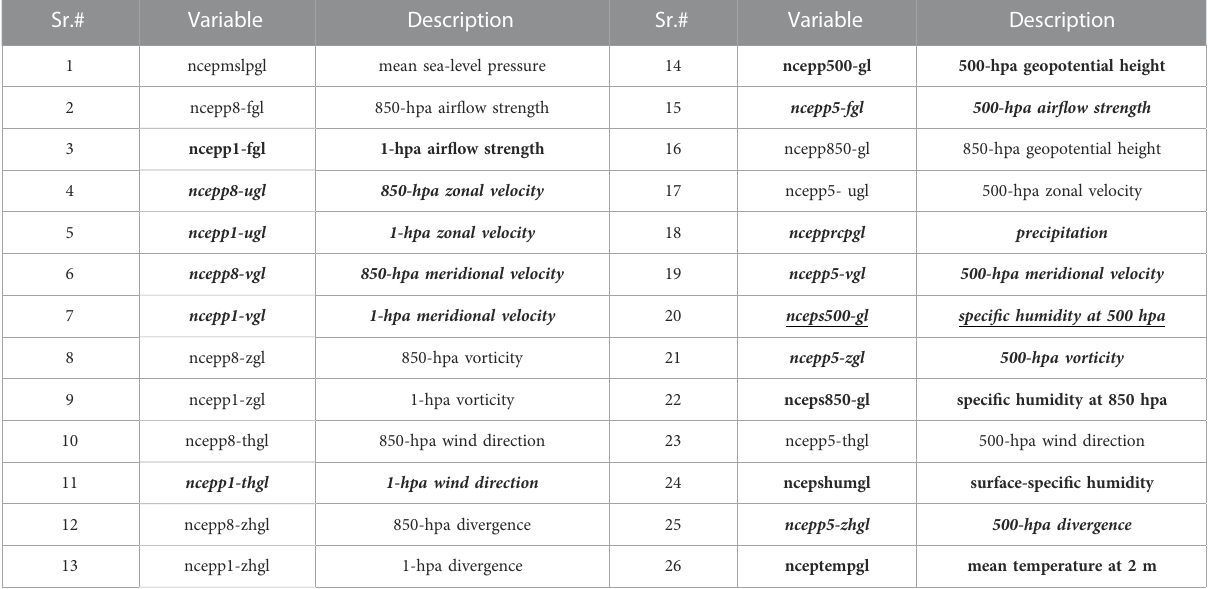
TABLE 3 Description of all NCEP variables (those in bold were chosen for model calibration). Sr.#